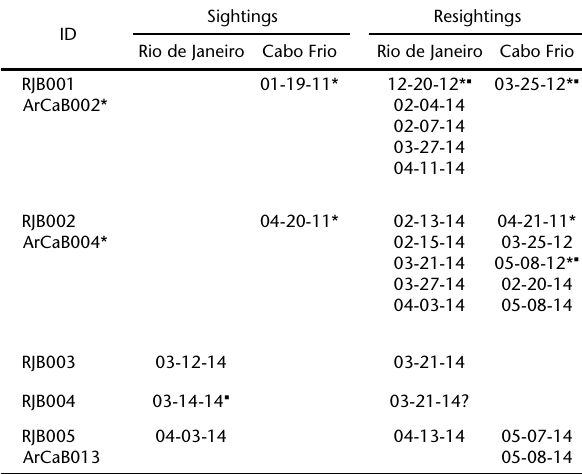
Table 2. Sightings and resightings of photo-identified Bryde’s whale, Balaenoptera edeni , in coastal waters off Rio de Janeiro and Cabo Frio region.